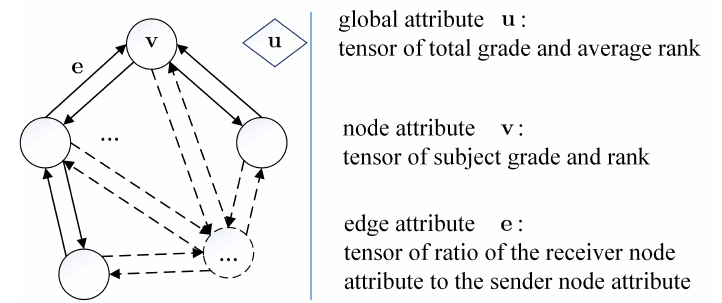
Figure 5. Graph network block of student grade prediction.